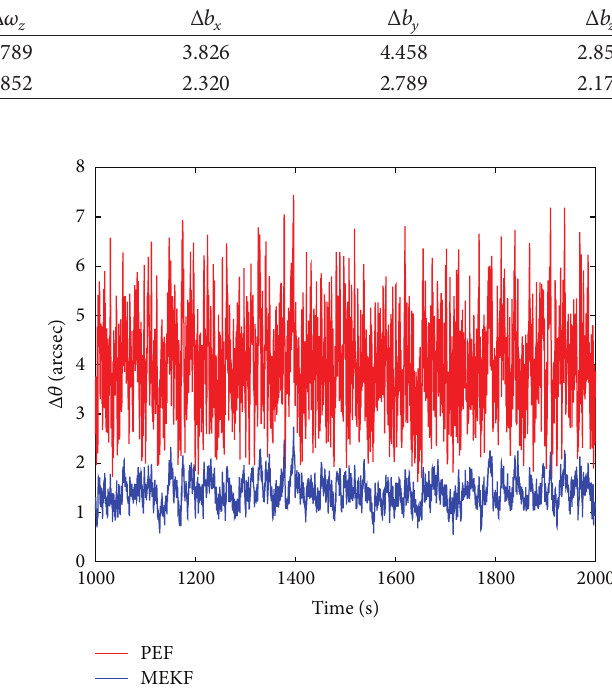
Figure 5: Initial attitude angle estimation errors.